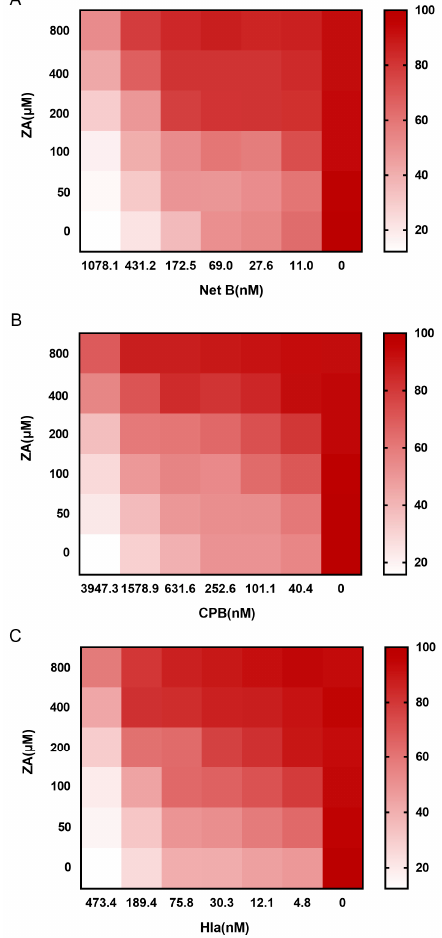
Figure 9. ZA reduces the toxicity of other pore-forming toxins. MDCK cells were incubated with ZA for 30 min, then exposed to Clostridium perfringens Net B (Net B) ( A ), Clostridium perfringens β -toxin (CPB) ( B ), or Staphylococcus aureus α -hemolysin (Hla) ( C ), and observed for 1 h.